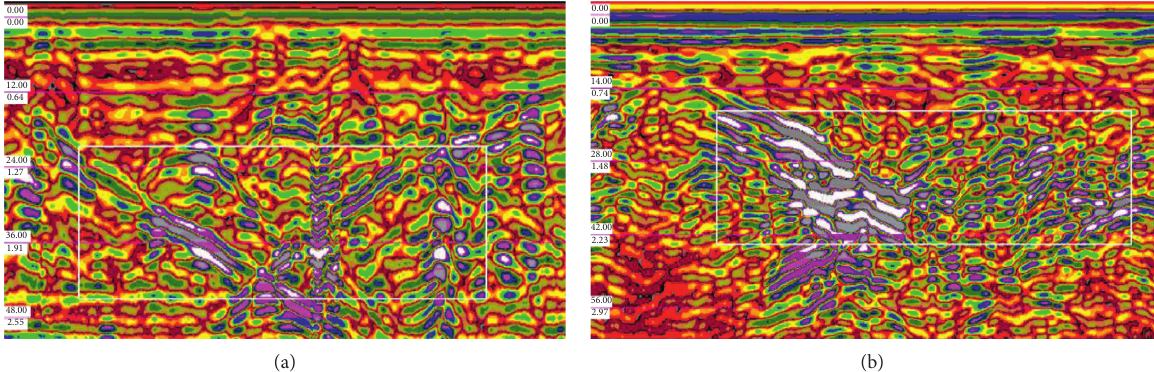
Figure 2: Radar detection maps of tunnel bottom structure fracture and water rich zone. (a) Fracture zone. (b) Water rich